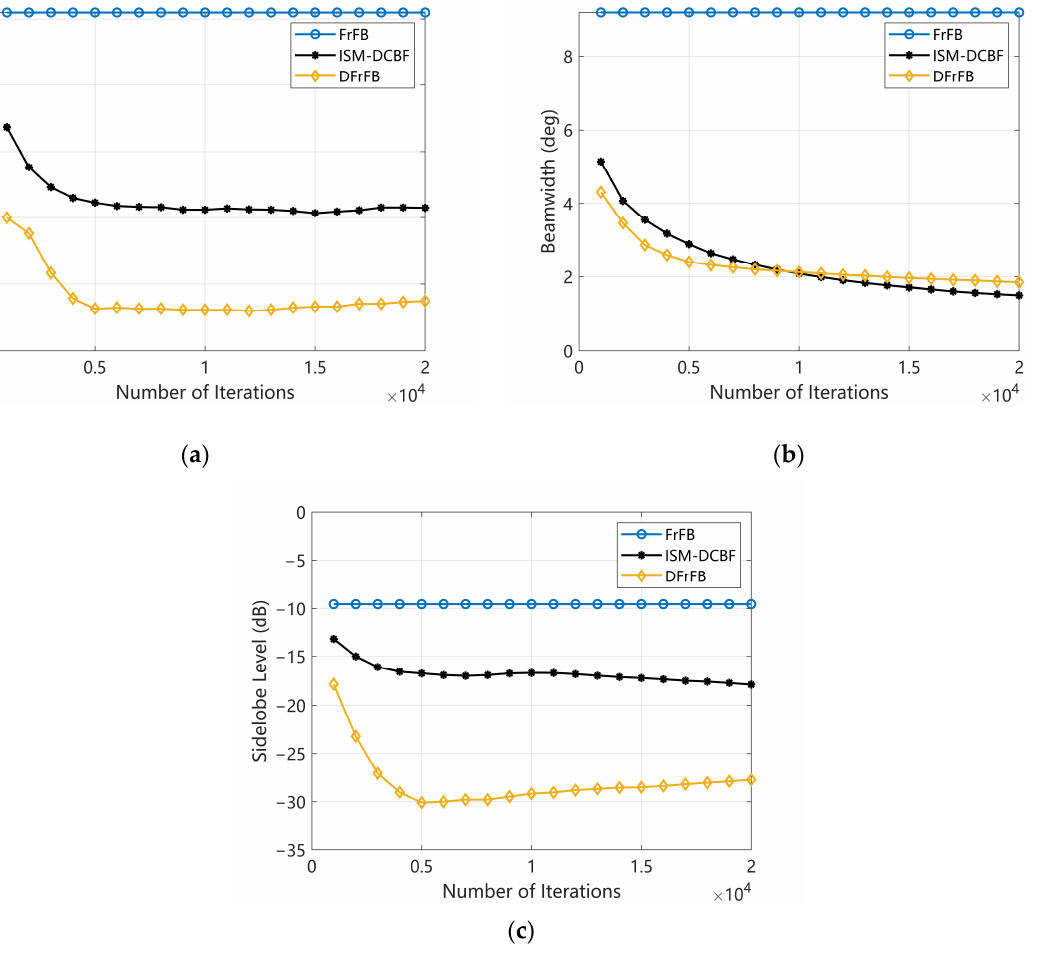
Figure 3. The performances of FrFB, ISM-DCBF, and DFrFB versus the number of iterations. ( a ) The RMSE; ( b ) the beamwidth; ( c ) the sidelobe level.